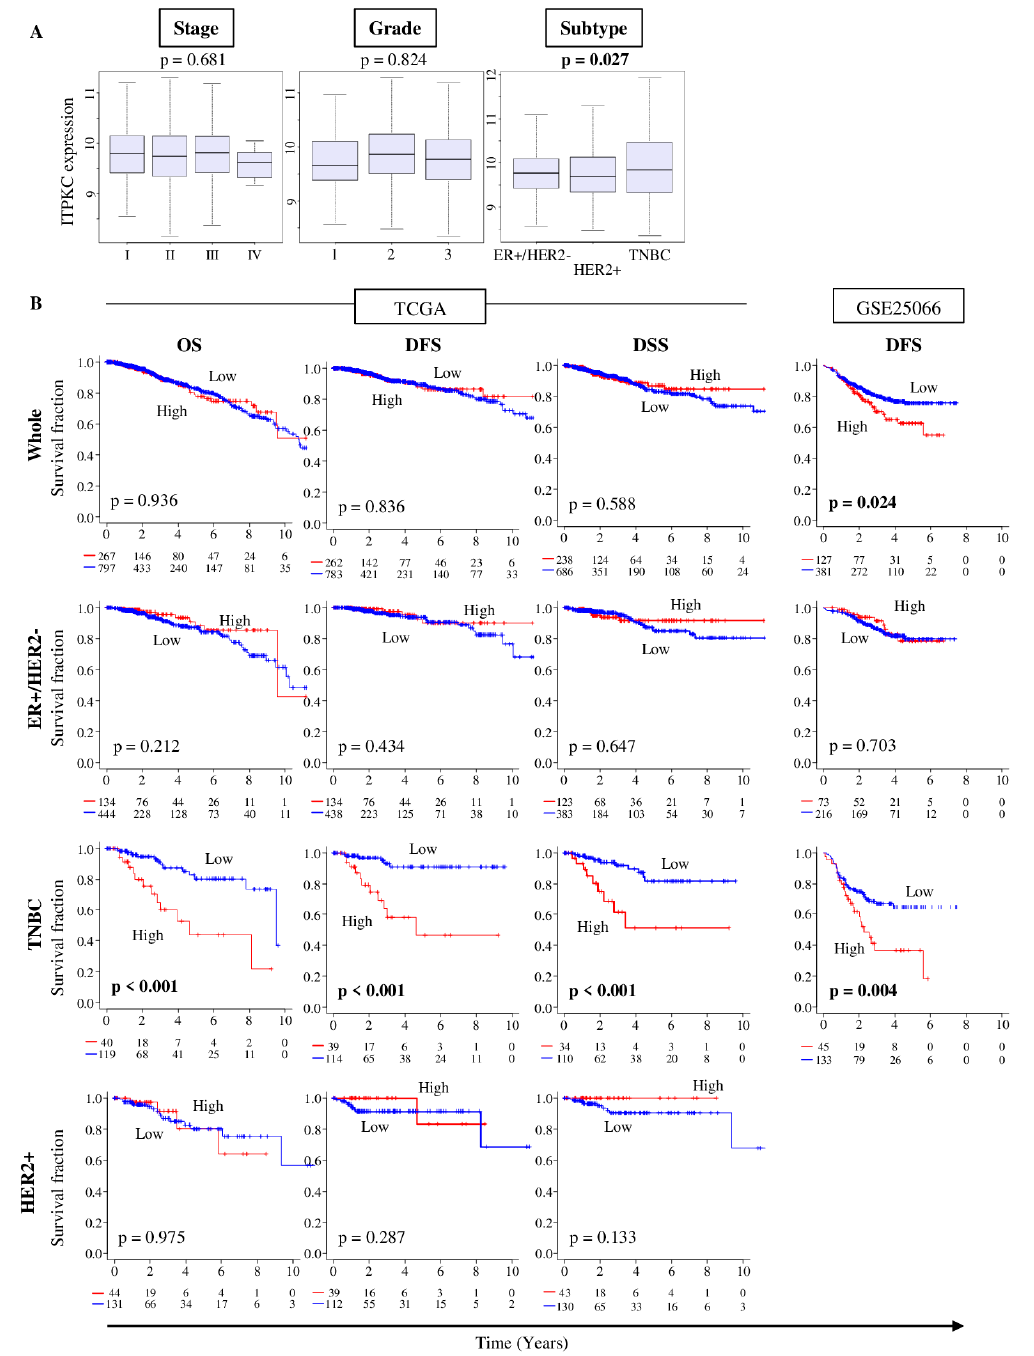
Figure 2. ITPKC gene expressions and clinical features including survival in the TCGA and GSE5066 breast cancer cohort. ( A ) Boxplots of the ITPKC expression by American Joint Committee on Cancer (AJCC) stage, Nottingham pathological grade and breast cancer subtype. One-way ANOVA test was used to calculate p values. Tukey-type boxplots show median and inter-quartile level values. ( B ) Association between ITPKC expression and survival of breast cancer patients in the TCGA and GSE25066 cohorts. Overall survival (OS), disease-free survival (DFS) and disease-specific survival (DSS) of ITPKC expression low and high in whole breast cancer cohort (Whole), estrogen receptor-positive / human epidermal growth factor receptor 2-negative (ER +/ HER2-), triple negative breast cancer (TNBC) and HER2 + in the TCGA cohort and DFS in the GSE25066 cohort. The top quartile was defined as the high-score group within each cohort. Log rank test was used to compare between two groups with Kaplan–Meier survival curves and to calculate p